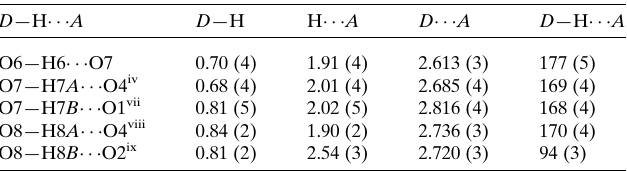
Table 2 Hydrogen-bond geometry (A˚ , (cid:5) ).